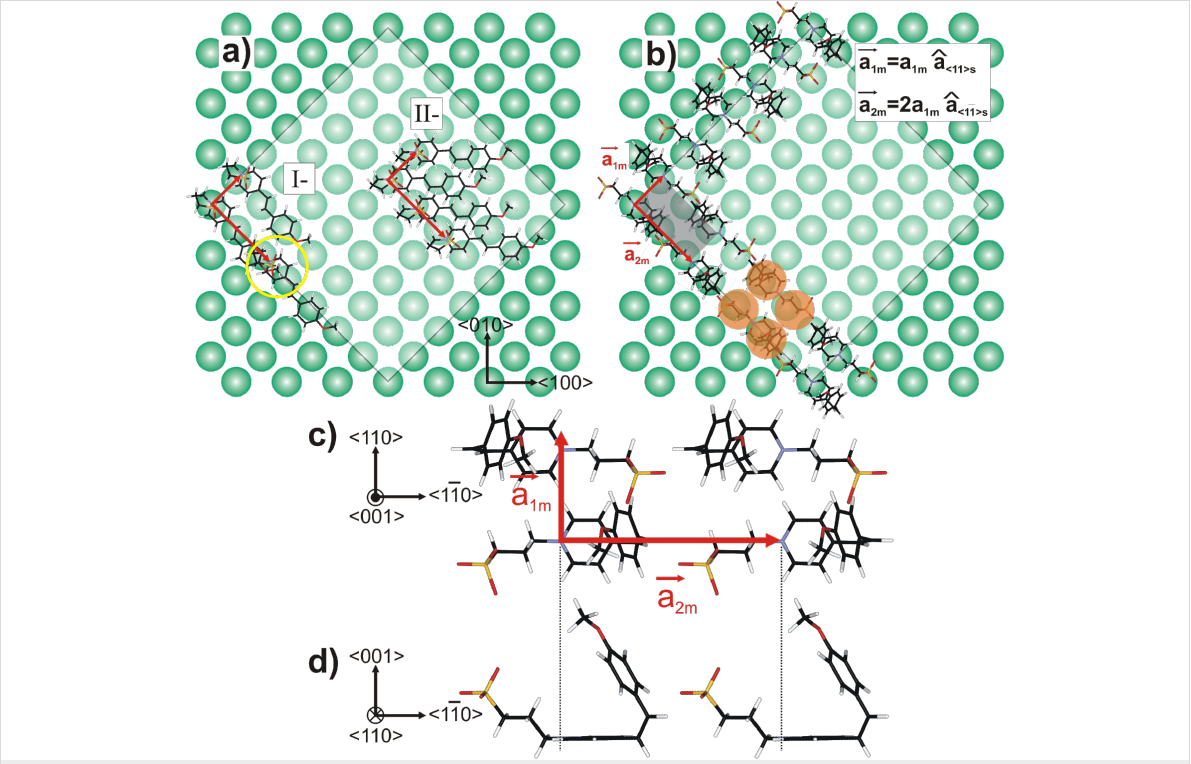
Figure 4: Conformations of MSPS on KCl(001). Only the positions of the substrate anions have been drawn. In (a) and (b), the white area depicts one patch of the molecular Moiré, as experimentally derived on KCl(001): = 31 × 31 Å 2 , = = 4.65 Å being the interionic distances along the and directions, respectively. (a) MSPS adsorbed in the scorpion-like conformation with molecular rows parallel to the direction (I) and to the direction (II). Arrangements (I) and (II) do not match the experimental findings (see text). (b) MSPS in the agraffe- like conformation with the corresponding rectangular unit cell: a 1 m × a 2 m = 5.1 × 10.2 Å 2 aligned along the and directions, respectively. Note that a 2 m is twice as large, which reflects the fact that each molecule is composed of two protrusions along this molecular axis (orange areas). In the agraffe-like conformation, the MM interaction is increased due to the interaction between the zwitterionic part of one molecule and the dipole moment of the anisyl part of the neighboring molecule, as illustrated in the top view (c) and in the side view